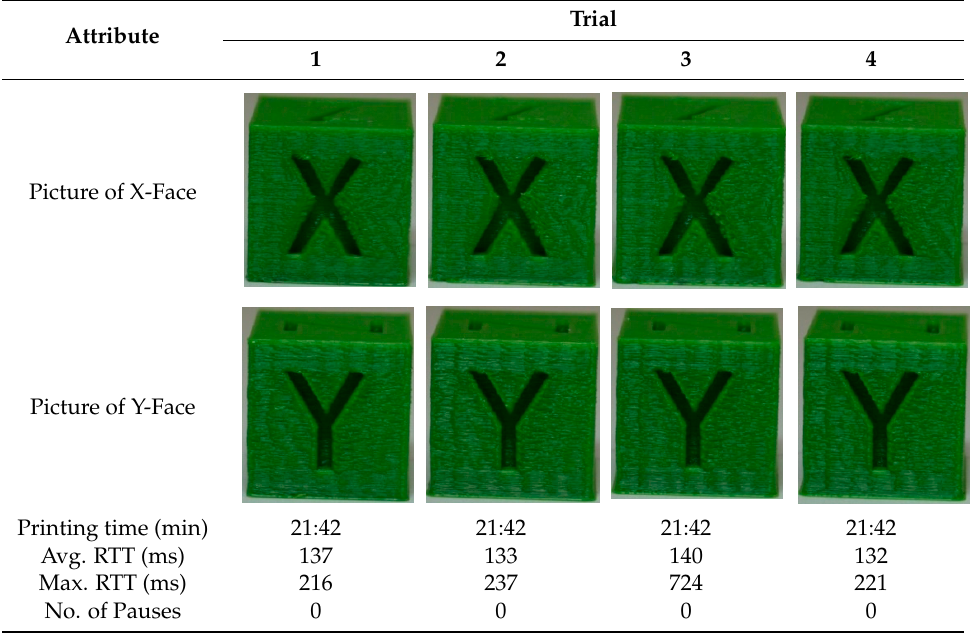
Table 6. Attributes of the Calibration Cube printed using a cloud-based controller stationed in Moncks Corner, South Carolina.